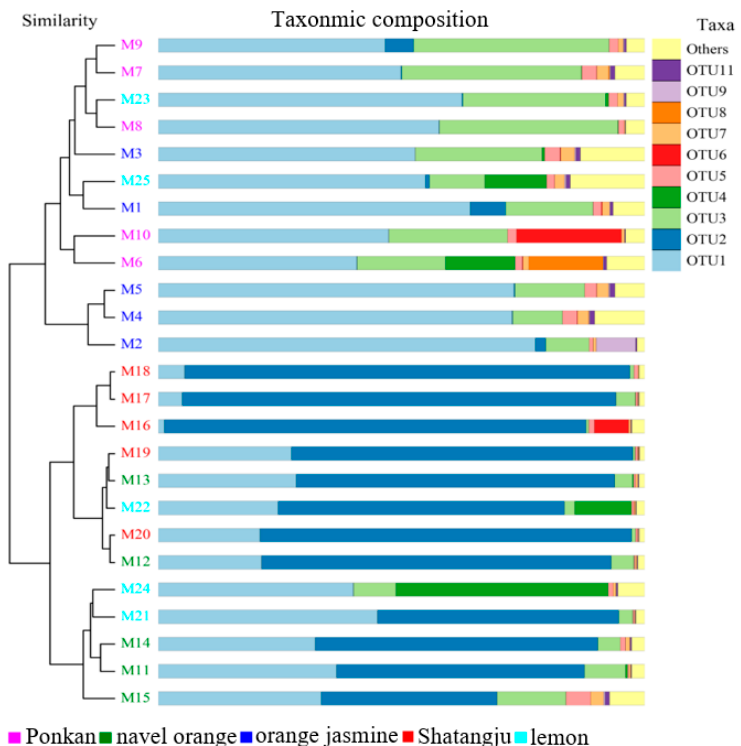
Figure 5. UPGMA clustering analysis of the microbiota based on weighted UniFrac distances.